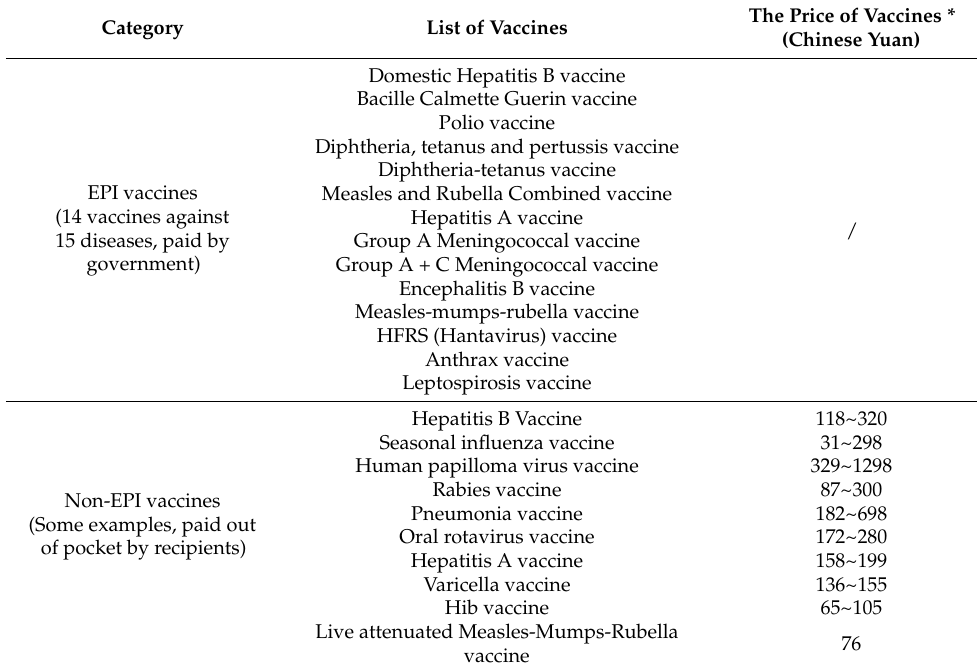
Table A1. Lists of EPI and non-EPI vaccines in China.